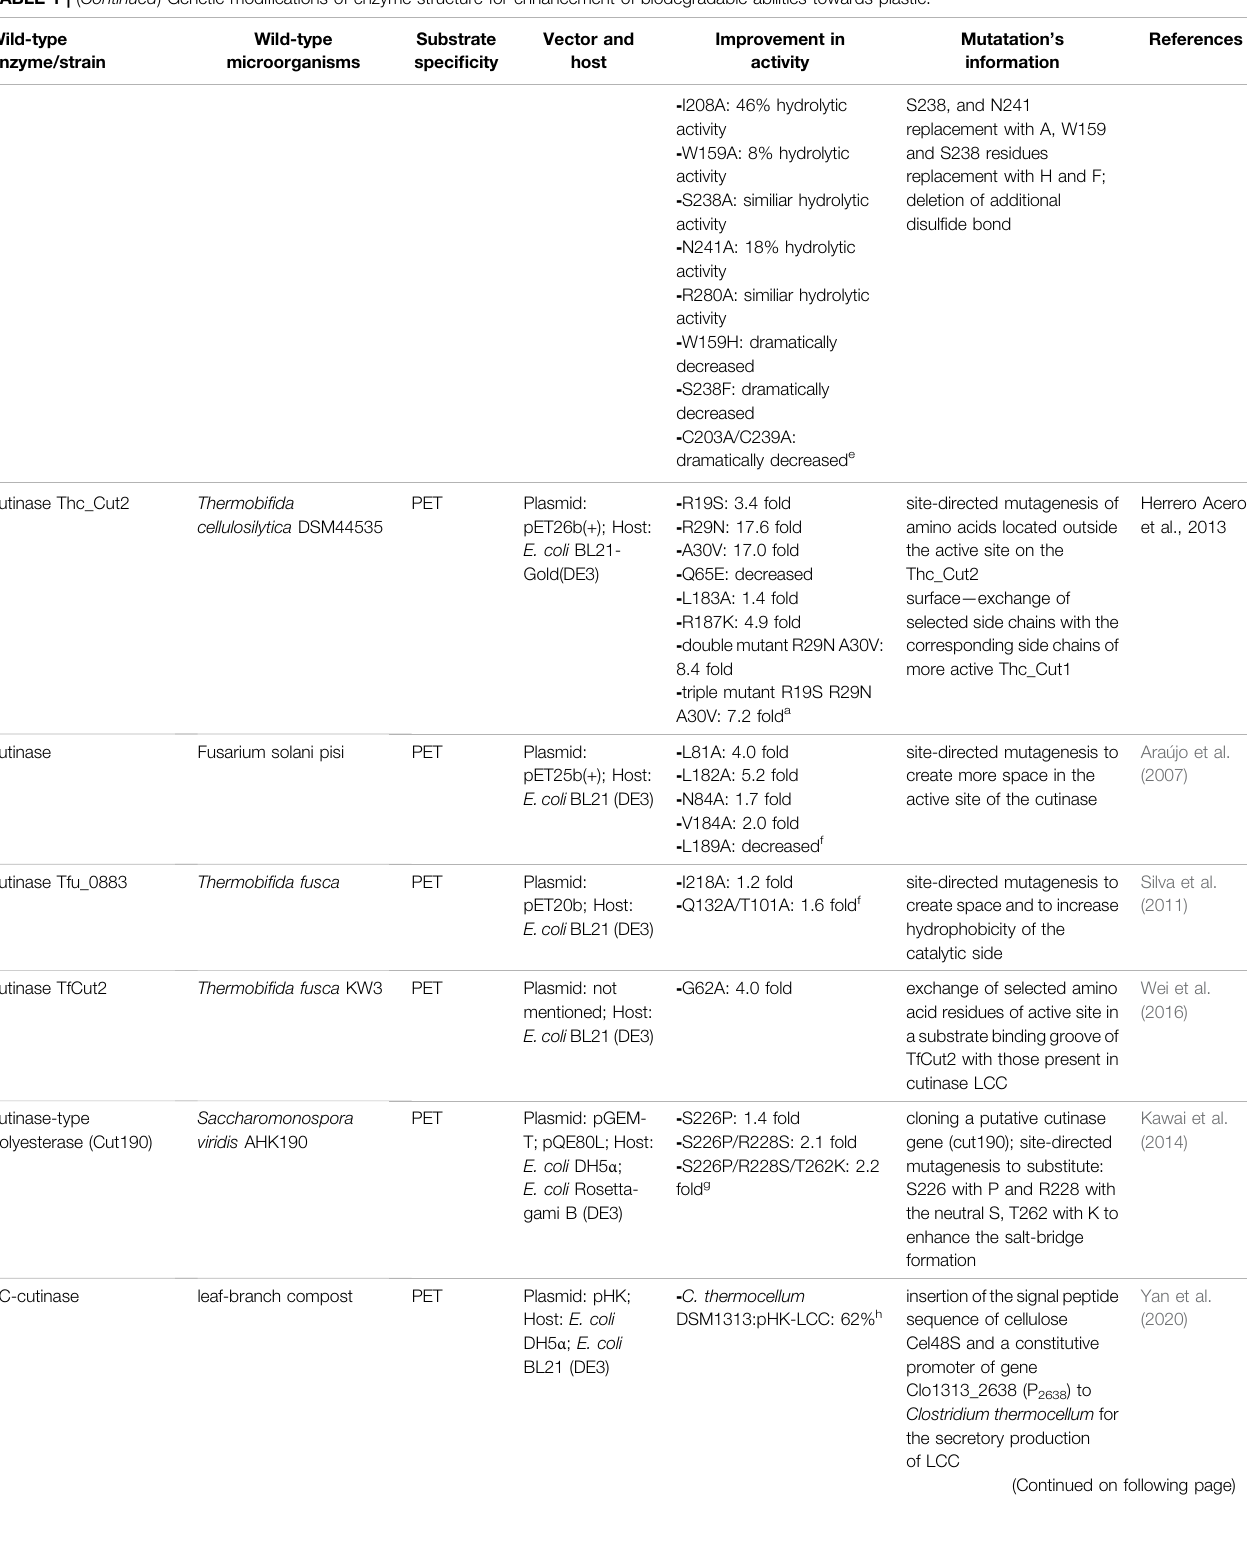
TABLE 1 | ( Continued ) Genetic modi fi cations of enzyme structure for enhancement of biodegradable abilities towards plastic. Wild-type